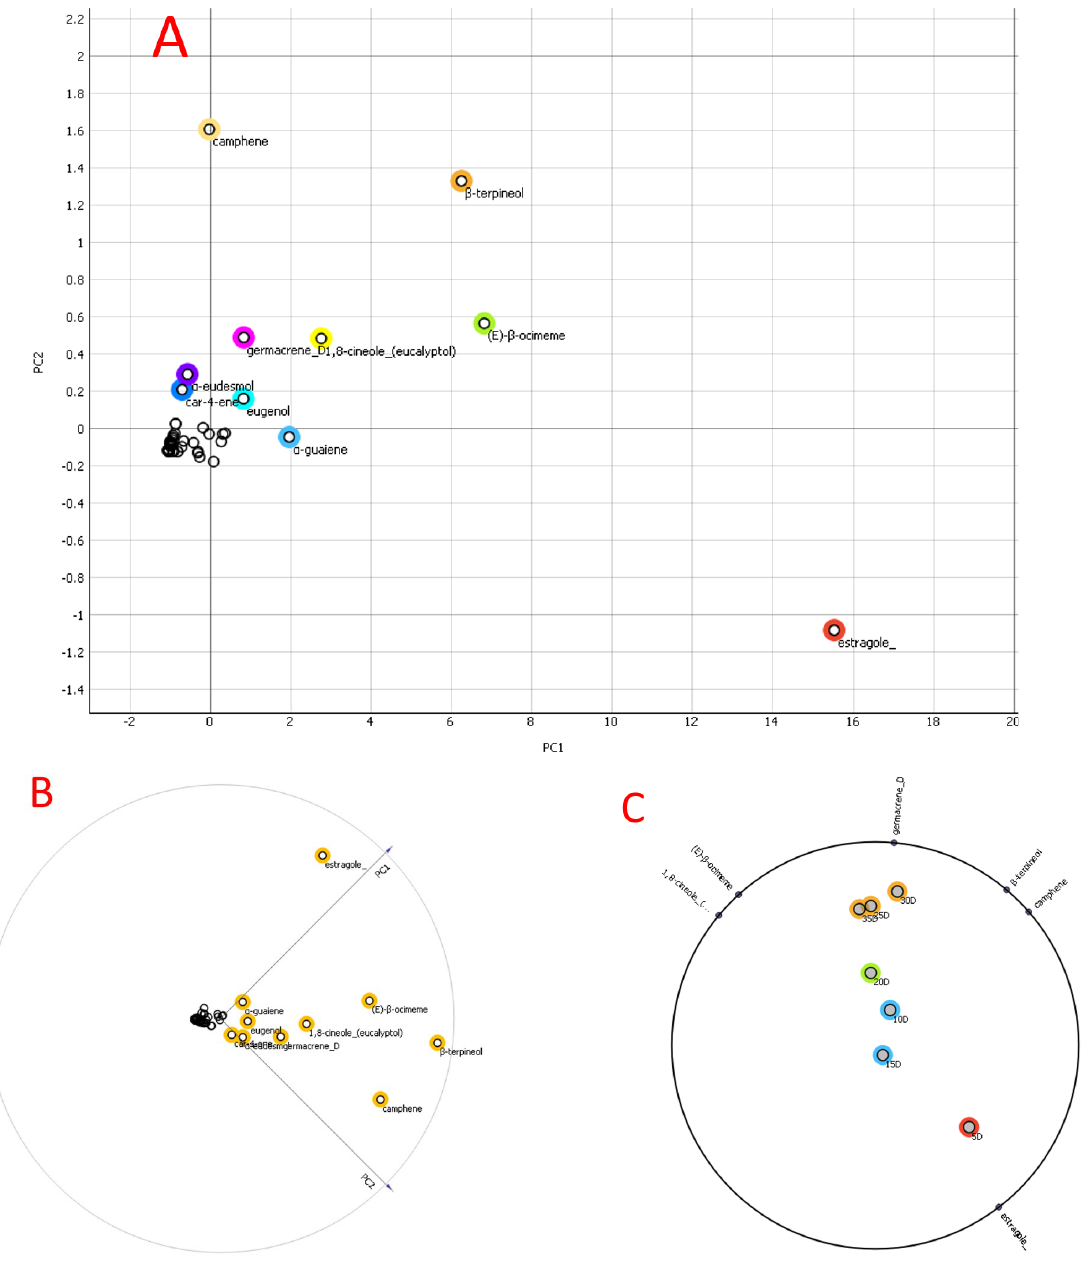
Figure 2. Principal component analysis (PCA) of the O. basilicum cell suspension extracts’ metabolite profiles throughout the initiation time (40 days); ( A ): loading plot and ( B , C ): score plot.